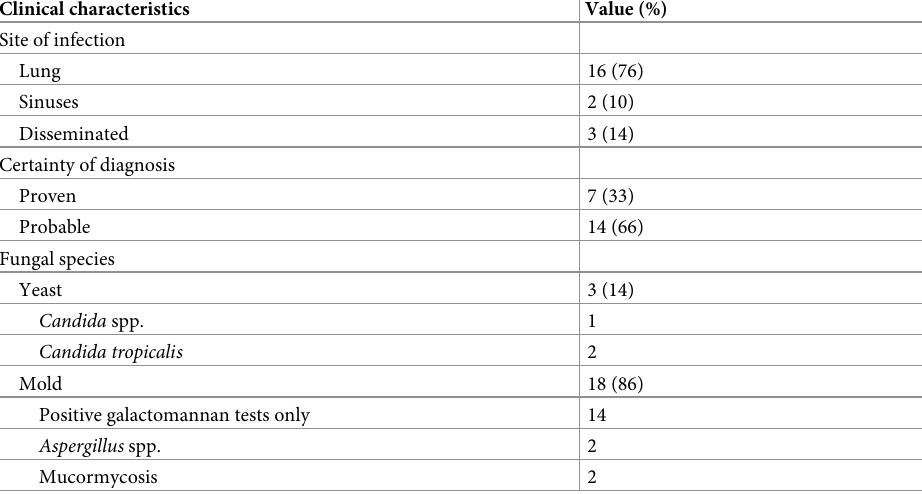
Table 2. Clinical characteristics of 21 cases of proven or probable invasive fungal infection among 105 Taiwanese patients with new diagnosed acute myeloid leukemia. Clinical